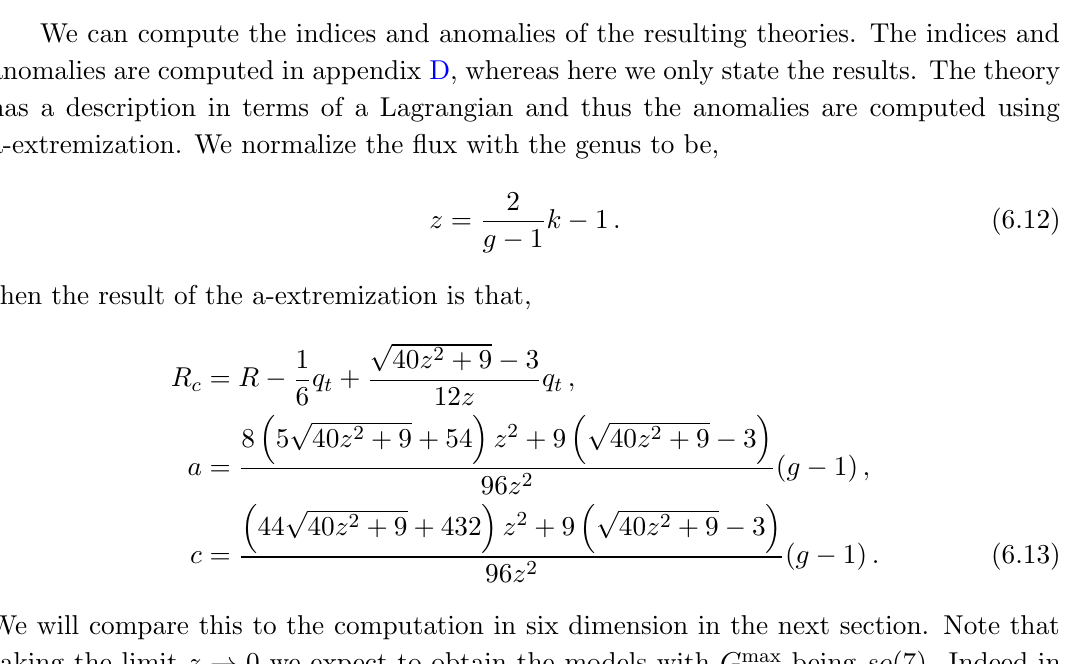
Figure 10 . Genus two theory with G max = so (7). Note that we can glue together any plus theory to an identical minus copy and obtain G max = so (7)